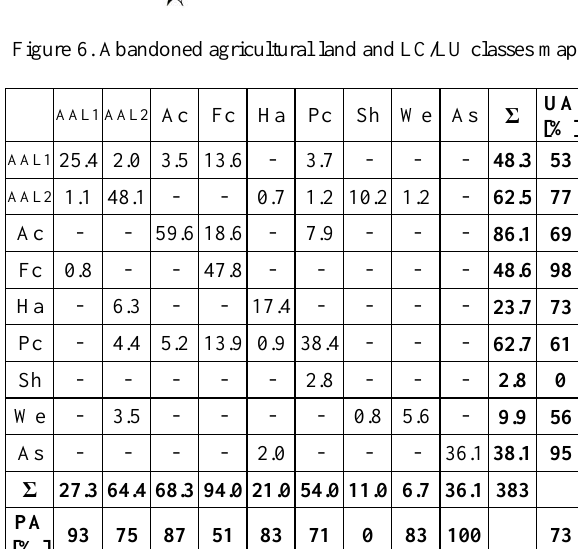
Table 5. Confusion matrix of RF classification where